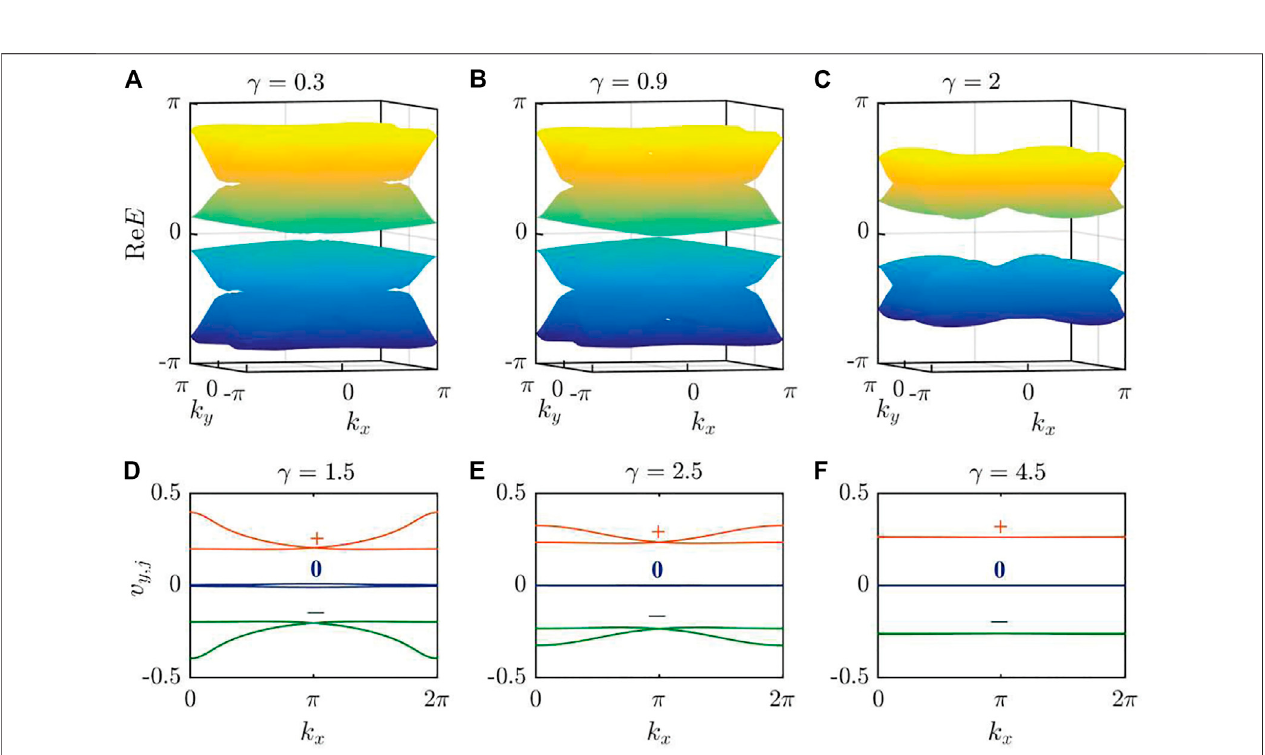
FIGURE 4 | (A – C) Real quasi-energy spectrum in momentum space of the effective Hamiltonian ^ H eff ( k ) with different gain-loss parameters. For the trivial (A) and topological (C) phases, therealspectrumsaregapped.Whileat thephase transitionpoint (B) ,the realspectrum isgapless. (D – F) Wannier bandsstructures v y , j ( k x ) with different gain-loss parameters. The imaginary parts are always zero. Here the coupling parameter is fi xed at J 1 = 1.1.